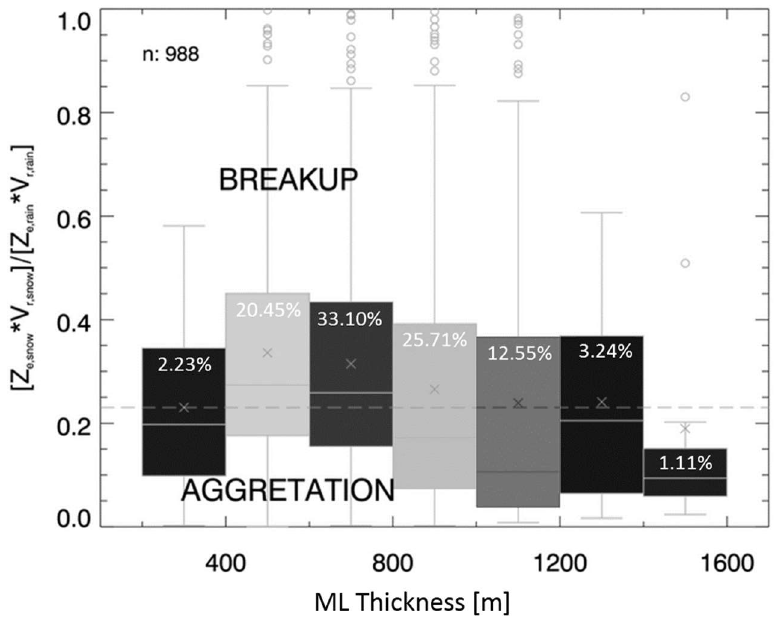
Figure 5. Box and whisker type plot with statistics represented similar to Figure 2 but showing particle flux across the ML as a function of ML thickness estimated from the XPR measurements in Huntsville, Alabama. The dashed line delineates MLs dominated by aggregation or breakup. The relative frequency of profiles in each ML thickness bin is indicated by the percentages.